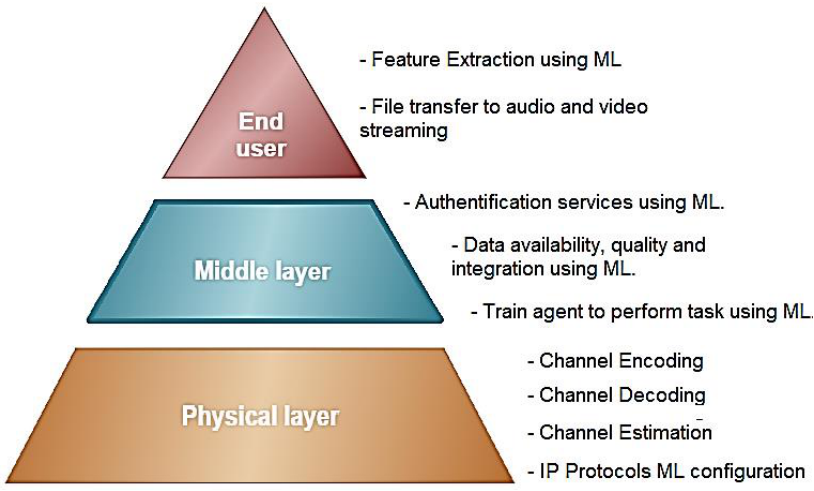
Figure 1. ML concern in physical, middle, and end-user layers.